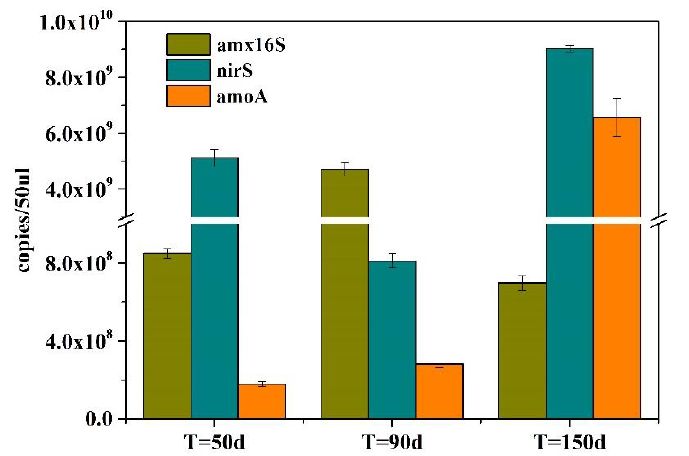
Figure 4. Abundances of nitrogen-metabolism-related functional genes in the MBBR at different operation times. amx16s: anammox 16s rRNA gene; nirS: nitrite reductase functional gene; amoA: ammonia oxidase functional gene.